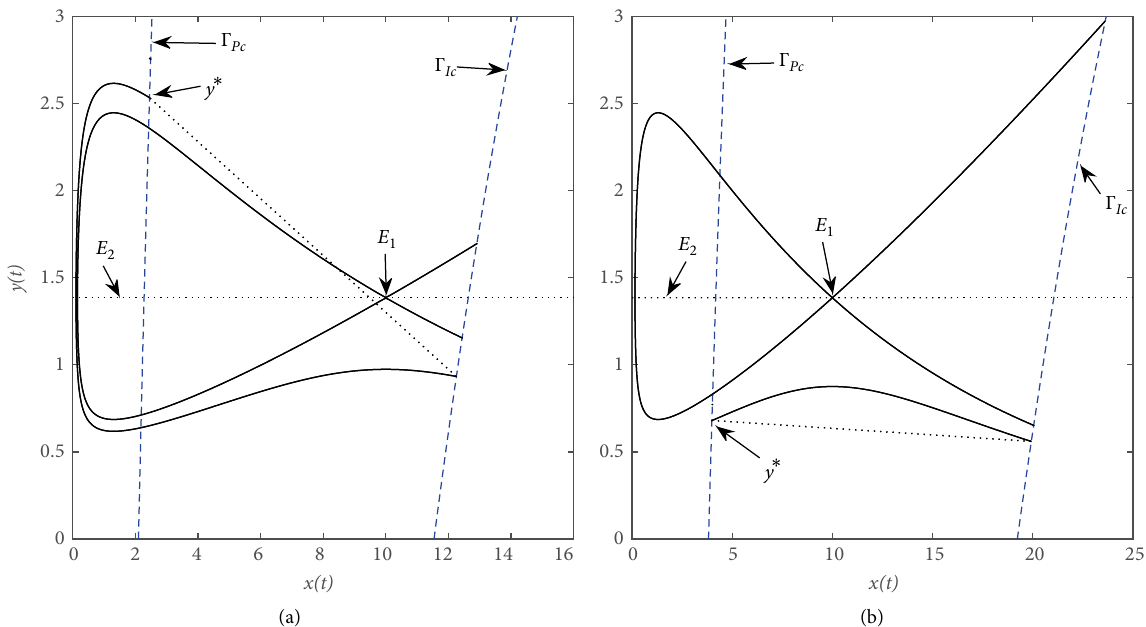
∗ , 푦 = 2.5330 , 훽 = 0.05 훼 = 0.95